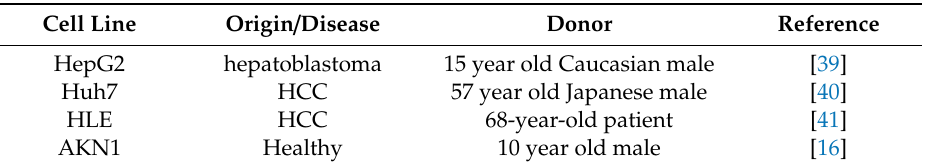
Table 1. Description of the used cell lines.